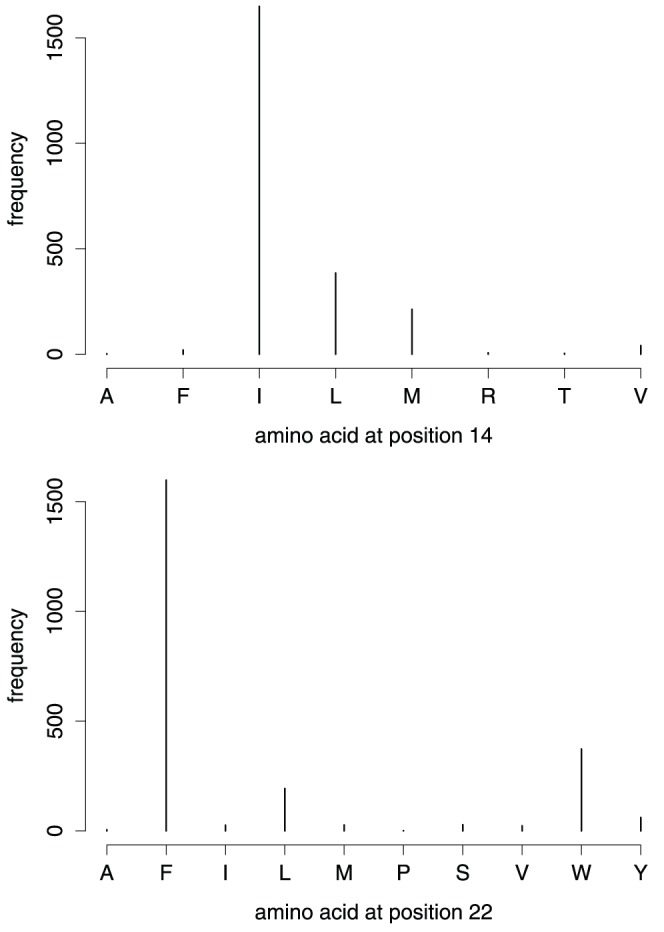
Amino acids at positions 14 and 22.The positions covered by signature pattern 1 have a preference for I and F, or, more generally, for hydrophobic amino acids at position 14 and aromatic residues at position 22. Frequencies from all Chinese and Non-Chinese samples in sequence data set.